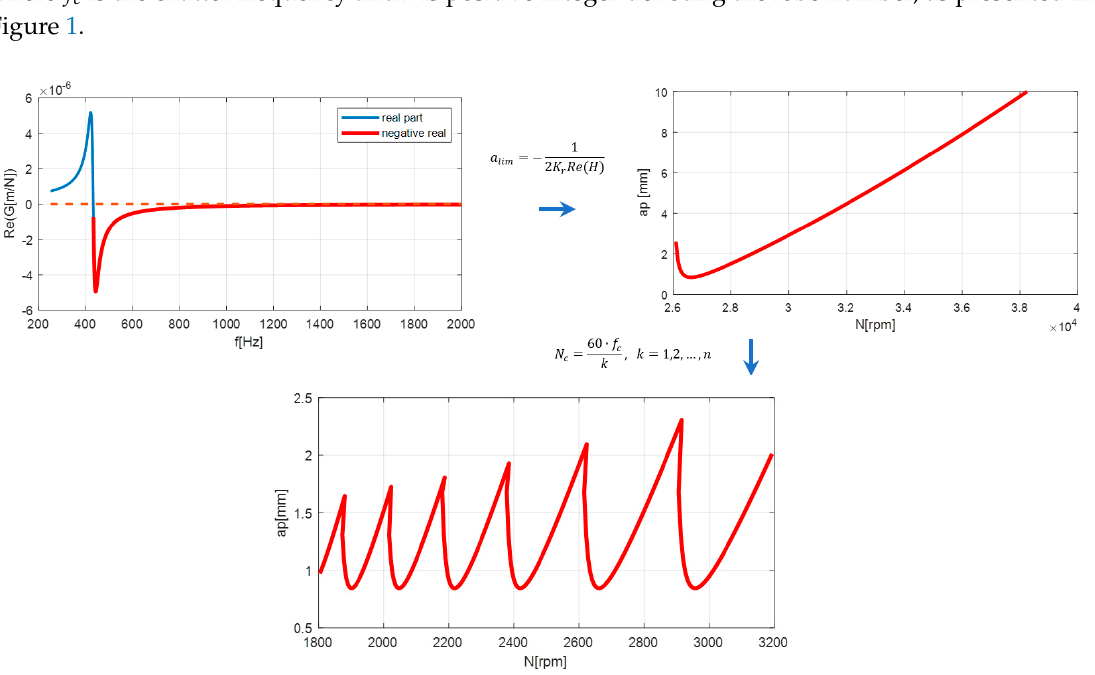
Figure 1. Stability lobes calculation procedure.